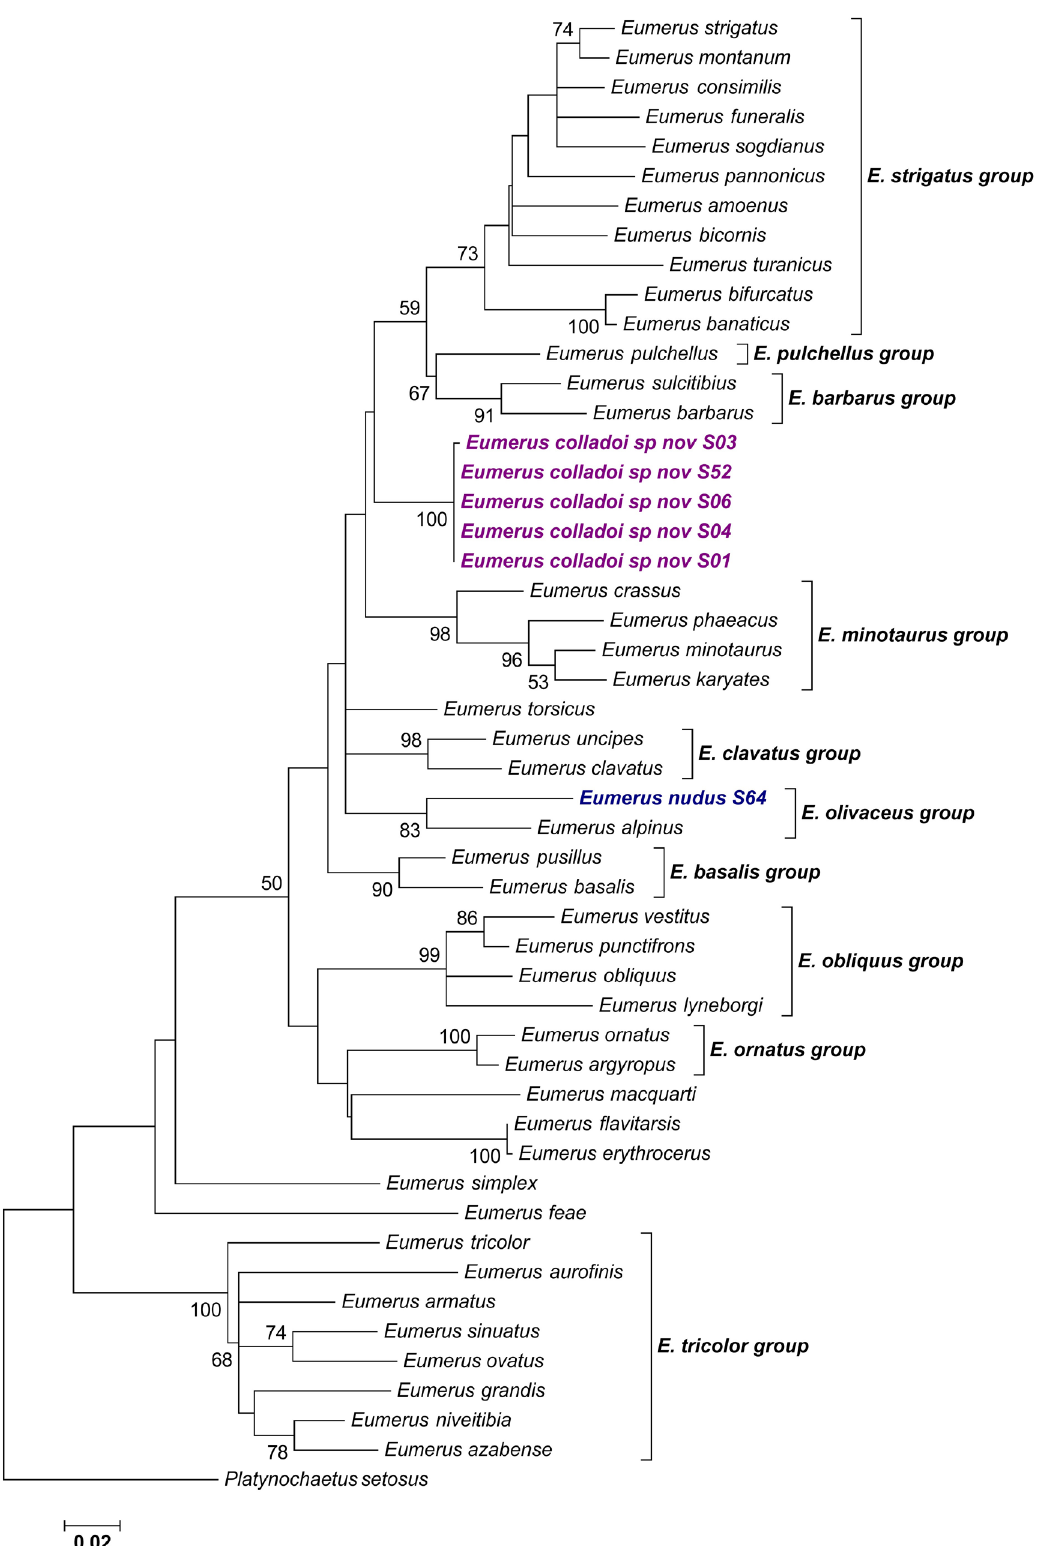
Fig. 8. Tree inferred using the Maximum Likelihood method. Bootstrap values > 50 are shown near nodes. Branch lengths measured in number of substitutions per